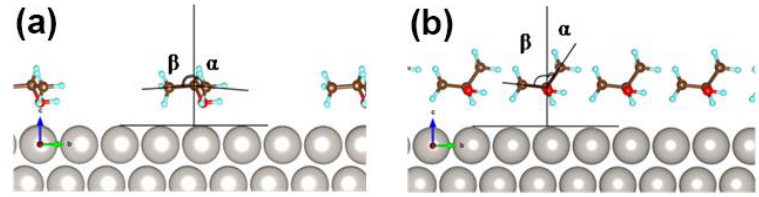
Figure 9. Minimum energy configurations of 2-PrOH molecules on Pt(111) surface for ( a ) gas phase (0.94 molecules/nm 2 ) and ( b ) liquid phase (3.75 molecules/nm 2 ) from DFT calculation (Pt—gray, C—brown, O—red, H—blue). (DFT results for 2-PrOH oxidation were reported in [22]. Reprinted with permission from [22]. Copyright 2014 American Chemical Society.). Table 2. 2-Propanol molecular orientations as angles of C–C bonds relative to surface normal, and nearest α-H-Pt distances for different concentrations of 2-propanol molecules on Pt(111) surface [22].